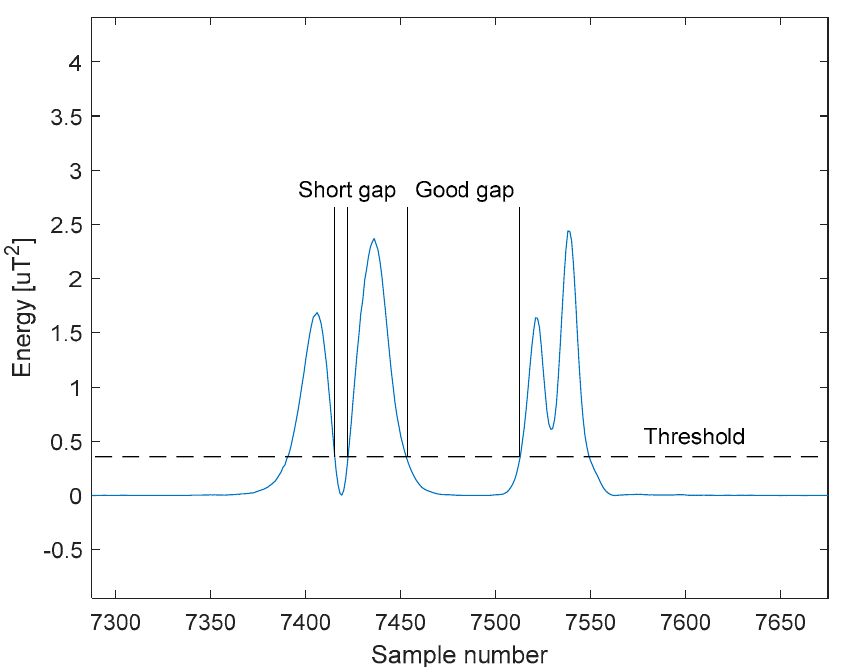
Figure 7. Example of gap length evaluation.